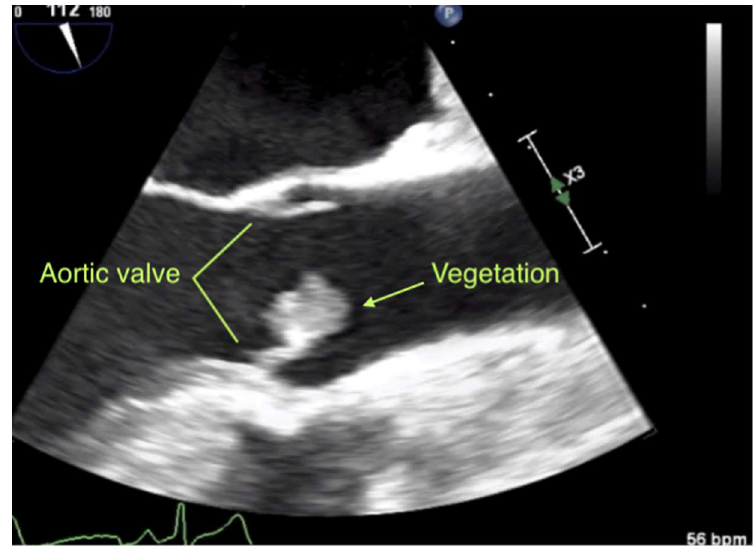
Figure 2. Ultrasound video (still). Transesophageal echocardiography performed in the long-axis view at midesophageal level. A visible echogenic mass, consistent with a vegetation of 12 × 12 × 10 mm 3 adhered to the native aortic